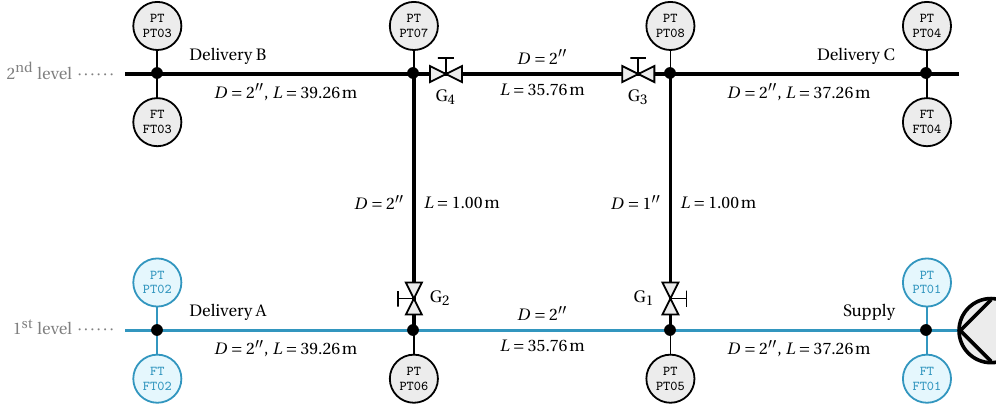
Figure 1. Complete configuration of the hydraulic network.